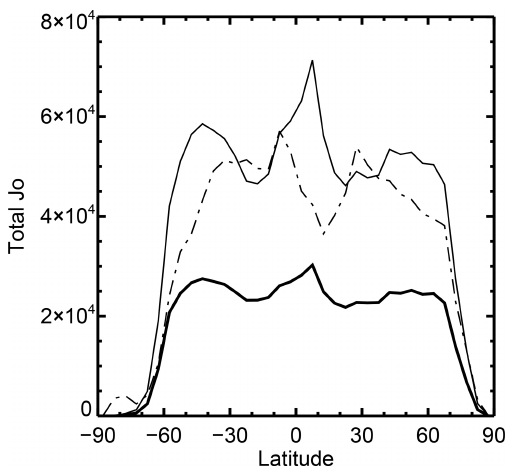
Figure 20. Total of the IASI WV channel contribution to the background observational cost function for Metop-A from 1 to 20 June 2017, accumulated in 5 ◦ latitude bins: clear-sky (dotted and dashed line), all-sky before VarQC (thin solid line) and after applying VarQC (thick solid line; this is a hypothetical calculation since VarQC is not applied until later in the